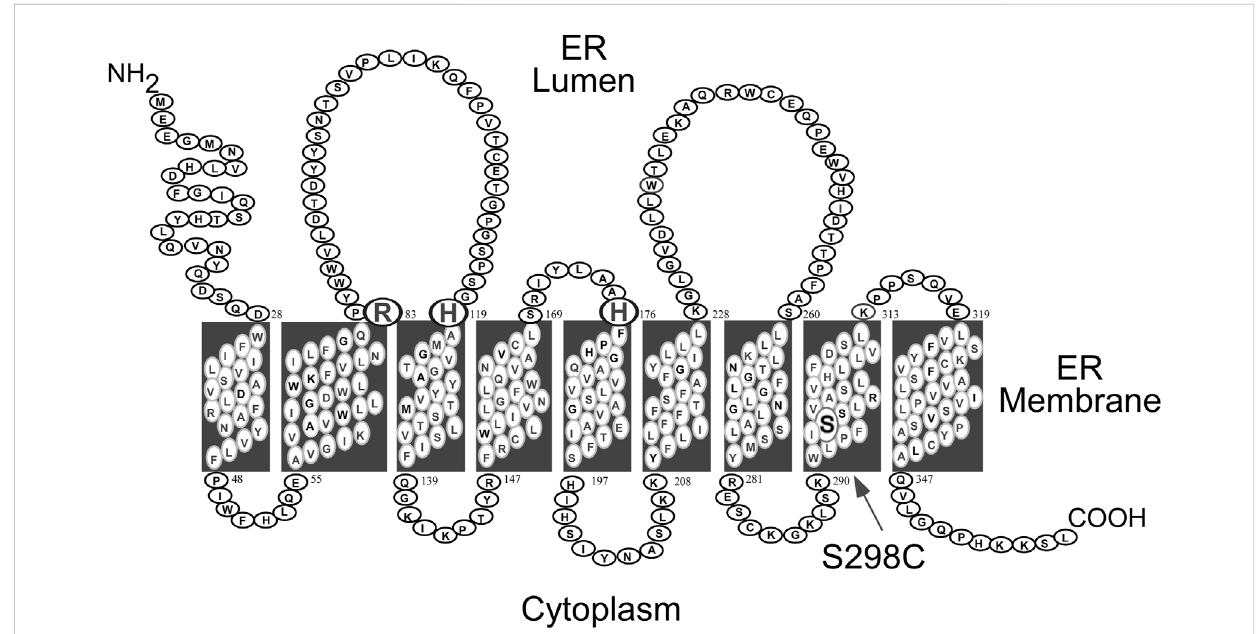
FIGURE 1 Human G6Pase- α is a 357 amino acid hydrophobic protein anchored in the ER membrane by nine helices (Pan et al., 1998). The amino acids comprising the catalytic center are highlighted by a larger font and include Arg-83, His-119, and the phosphate acceptor His-176, all situated on the luminal side of the ER (Ghosh et al., 2002). The S298C variant that increases catalytic activity (Zhang et al., 2019) is also